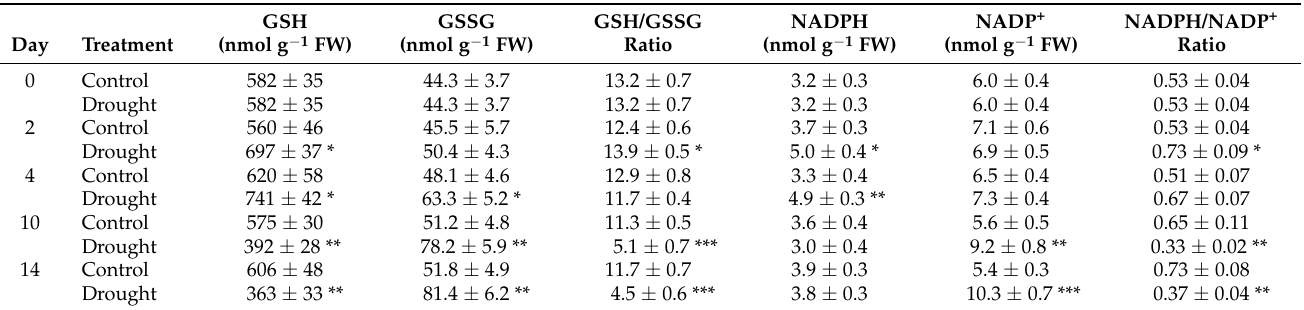
Table 2. Changes in GSH- and NADPH-based redox status in the leaves of Brassica napus 14 days after drought